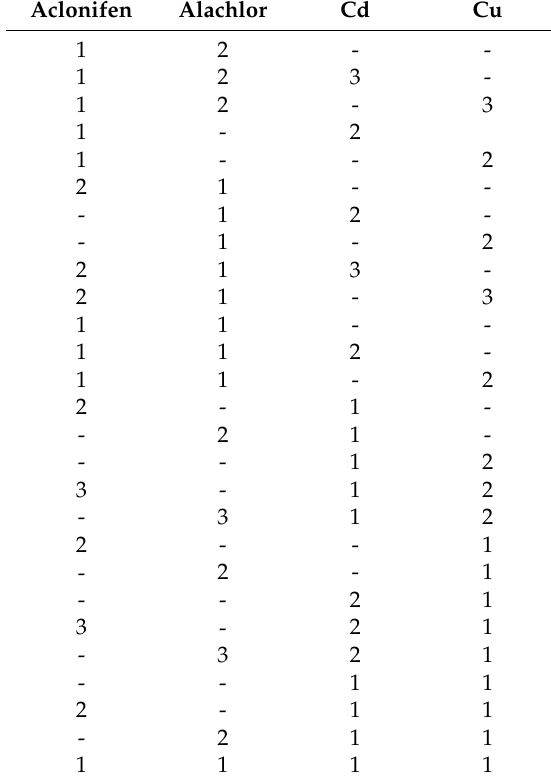
Table 1. Summary of the studied mixtures. Each line corresponds to a case study. The numbers represent the order of introduction in the mixture. Two pollutants with the same number were introduced simultaneously. Aclonifen